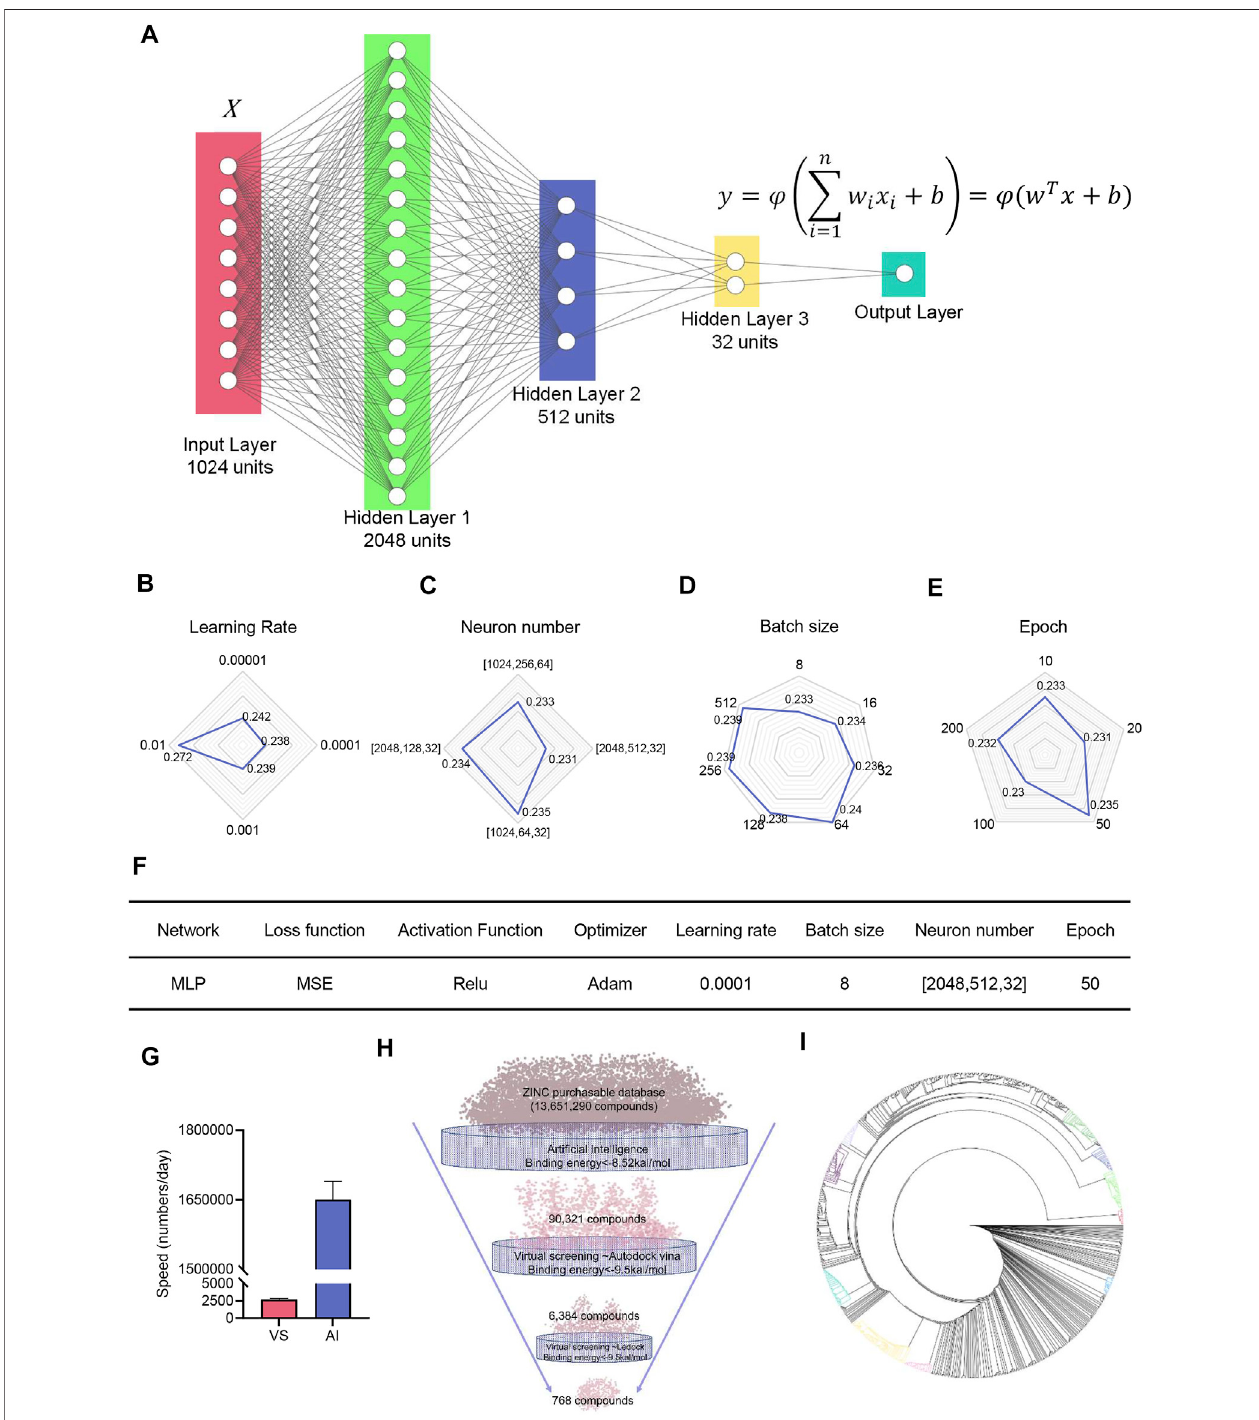
FIGURE 5 | Neural network built to accelerate the discovery of potential compounds targeting PEDV NTPase. (A) Structure of the deep neural network. Neurons are represented bycircles. (B – E) Tunningofhyperparameters. (F) Parameterand hyperparameter settings forthedeep neuralnetwork. (G) Comparison ofthespeedof virtual screening with arti fi cial intelligence. (H) Combination application of AI and VS to fi nd compounds with high binding energy to PEDV NTPase. (I) Clusters of compounds targeting PEDV NTPase with high binding energy.